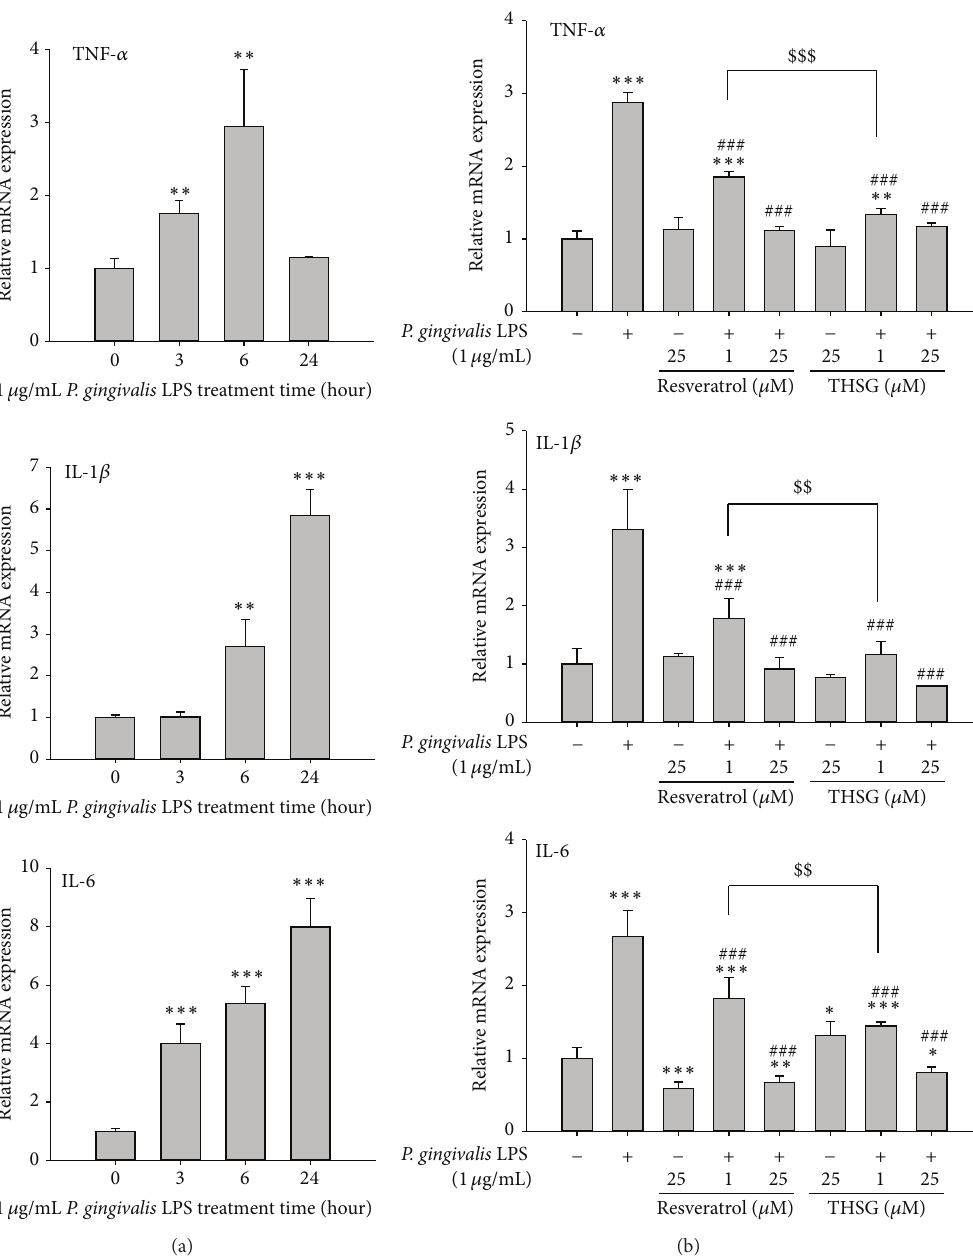
Figure 2: The anti-inflammatory effects of resveratrol and THSG in P. gingivalis LPS-treated HGFs. HGFs were cultured in 6-well plate and were starved with serum-free DMEM/F12 medium for 24h when the cell confluence reached 80%. (a) HGFs were treated with 1 𝜇 g/mL P. gingivalis LPS for 0, 3, 6, and 24 h. (b) HGFs were pretreated with resveratrol and THSG (1 and 25 𝜇 M) for 30 min and then were treated with 1 𝜇 g/mL P. gingivalis LPS for 6 h. Total RNA was extracted and reverse transcripted to cDNA, and then the quantitative PCR was performed. ( 𝑁 = 3 ; ∗ 𝑝 < 0.05 ; ∗∗ 𝑝 < 0.01 ; ∗∗∗ 𝑝 < 0.001 were compared with control group. ### 𝑝 < 0.001 were compared with LPS group. $$ 𝑝 < 0.01 ; $$$ 𝑝 < 0.001 were compared with 1 𝜇 M resveratrol group with LPS